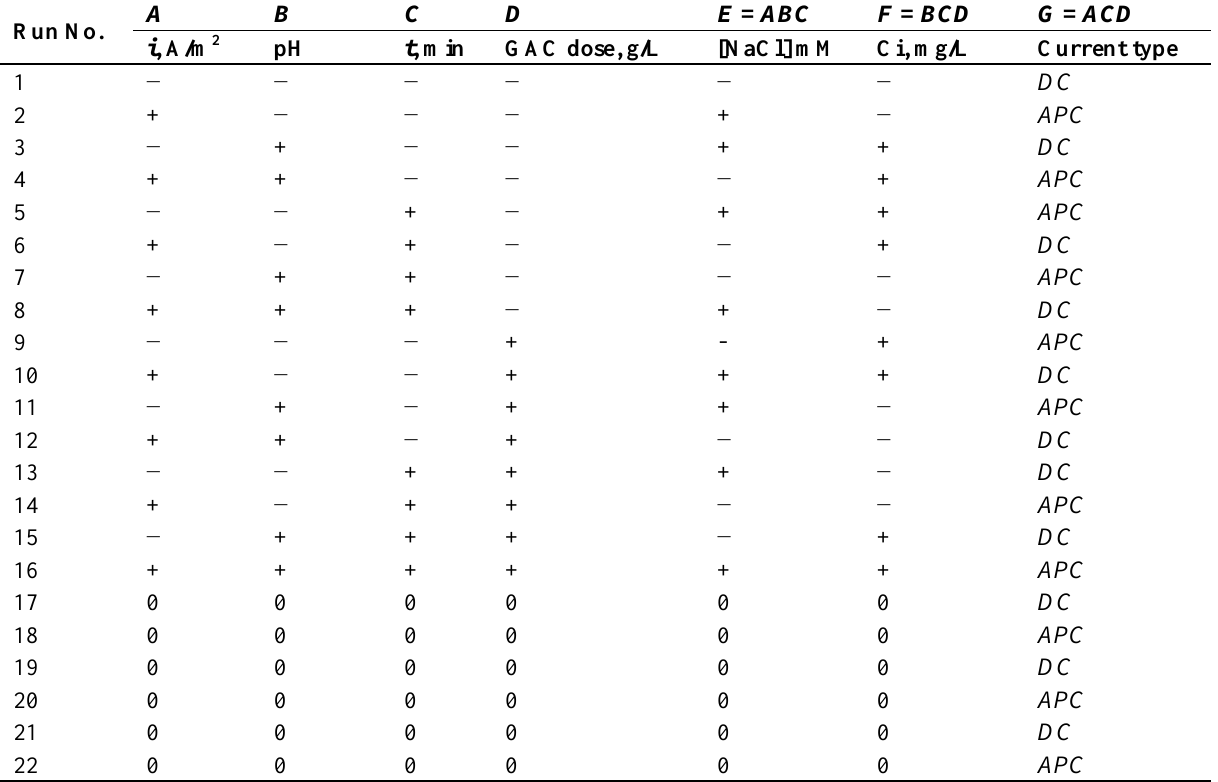
Table 3. Experimental design matrix of the 2 7-3 fractional factorial design ( FFD ). Run